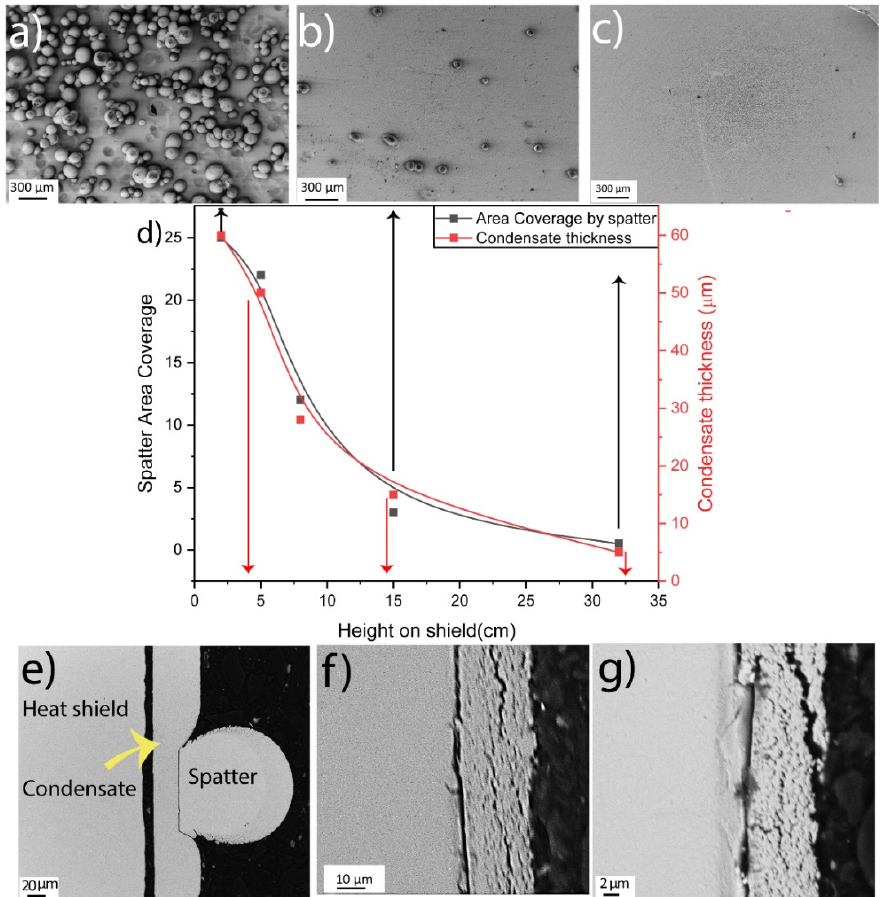
Figure 2. The top micrographs show area coverage by spatters from the ( a ) bottom (2 cm), ( b ) middle (15 cm), and ( c ) top (~32 cm) of the heat shield (distances from the bottom of the heat shield). The center plot ( d ) shows the variation in area coverage by spatter particles and condensate thickness with height on the heat shield. The bottom micrographs show the condensate thickness ( e ) at the bottom (2 cm), ( f ) middle (15 cm), and ( g ) top (32 cm) of the heat shield.